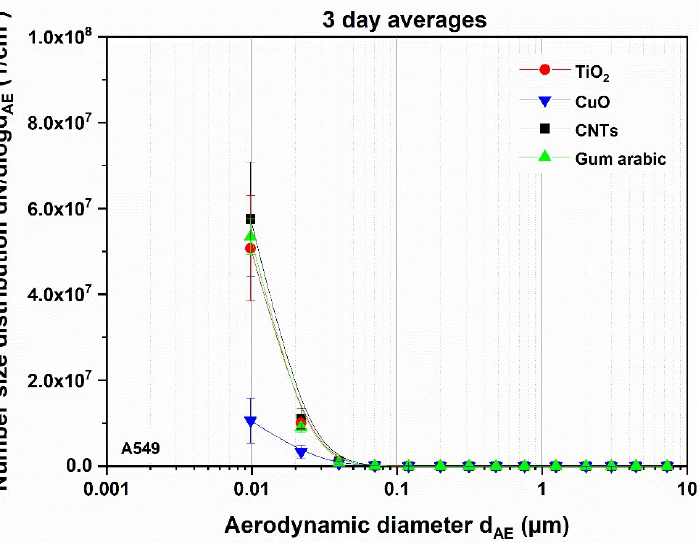
Figure 2. Average measured number size distributions of the different nanomaterial suspensions downstream of the thermal treatment, as determined via ELPI, subsequently applied to A549 cells. Error bars indicate standard deviation derived from three independently performed experiments.